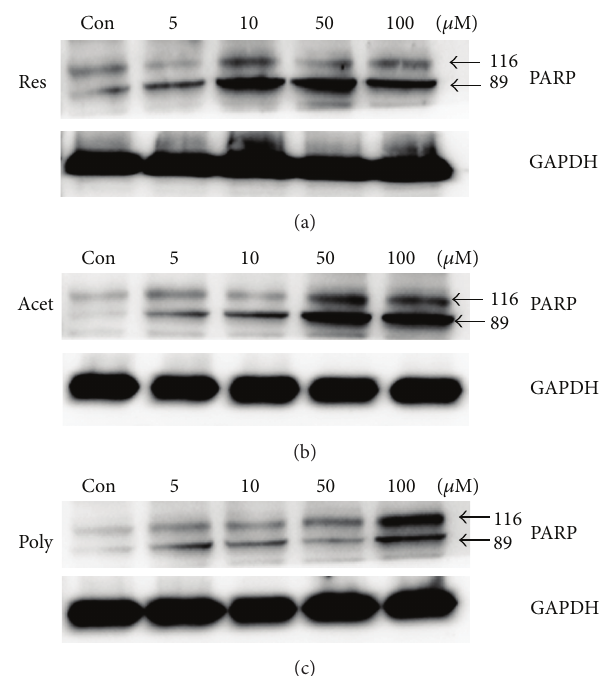
Figure 3: The effect of resveratrol (a), acetyl-resveratrol (b), and polydatin (c) on the expression of poly(ADP-ribose) polymerase (PARP) which was used as an indicator of apoptosis in SKOV-3 cell aggregates. At higher concentrations resveratrol, acetyl-resveratrol, and polydatin increased the fragmentation of PARP giving a band of 89 kDa which was indicative of apoptosis. At 10 𝜇 M resveratrol induced the fragmentation of PARP. Based line expression of PARP at 116 and 89 kDa was observed in controls and low doses of all compounds.